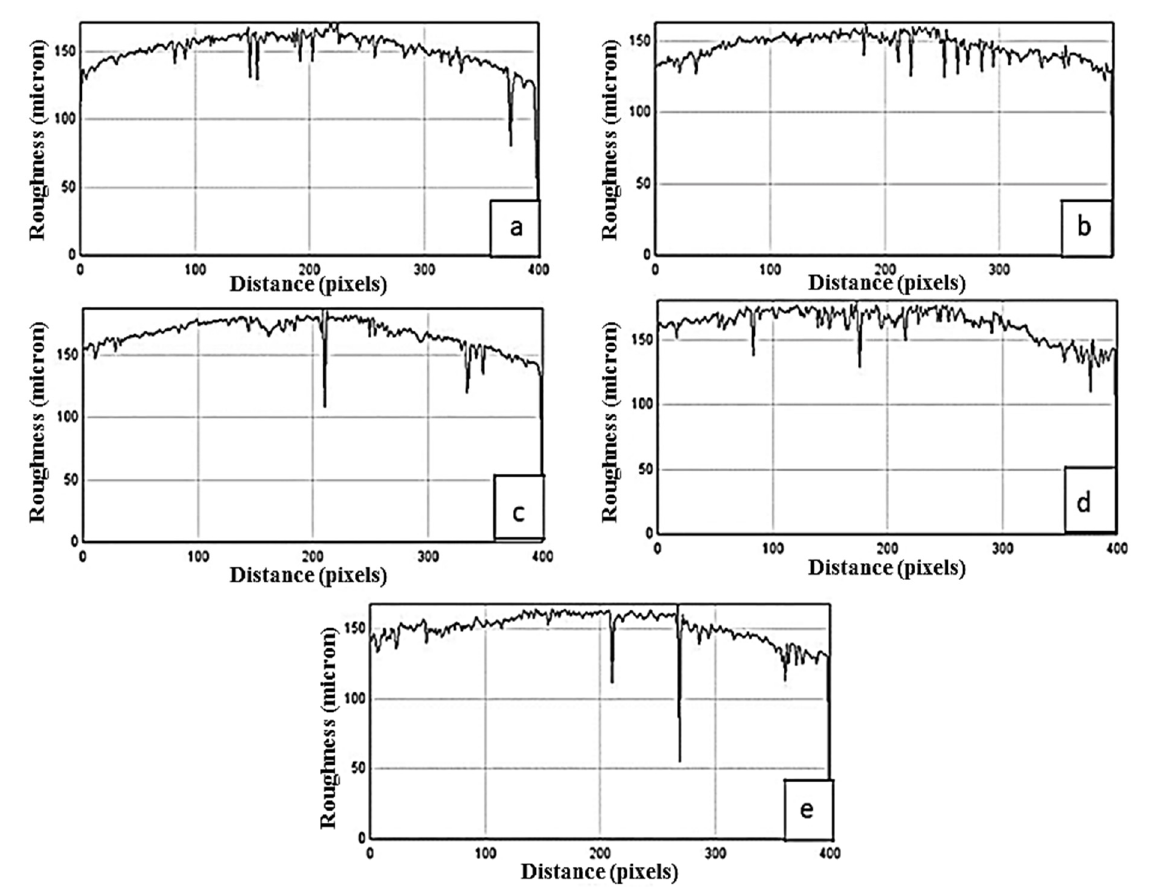
Figure 4. Surface roughness of 10% Mg-doped AlSb films at different deposition times ( a ) 1 h, ( b ) 1.5 h, ( c ) 2 h, ( d ) 2.5 h, and ( e ) 3 Table 3. Surface roughness of pure and Mg-doped AlSb thin films at different deposition times.